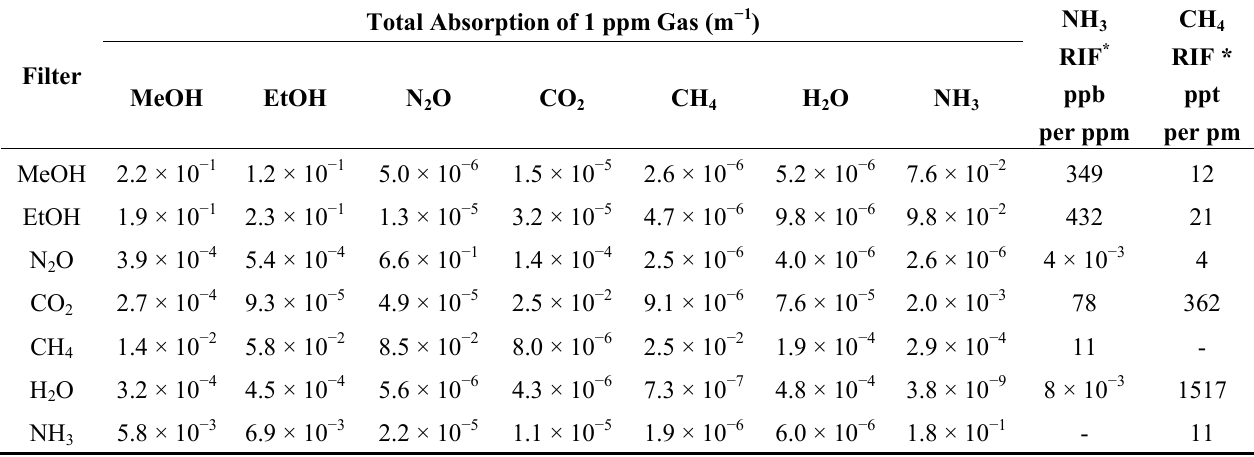
relative interference on target gases in Example 4